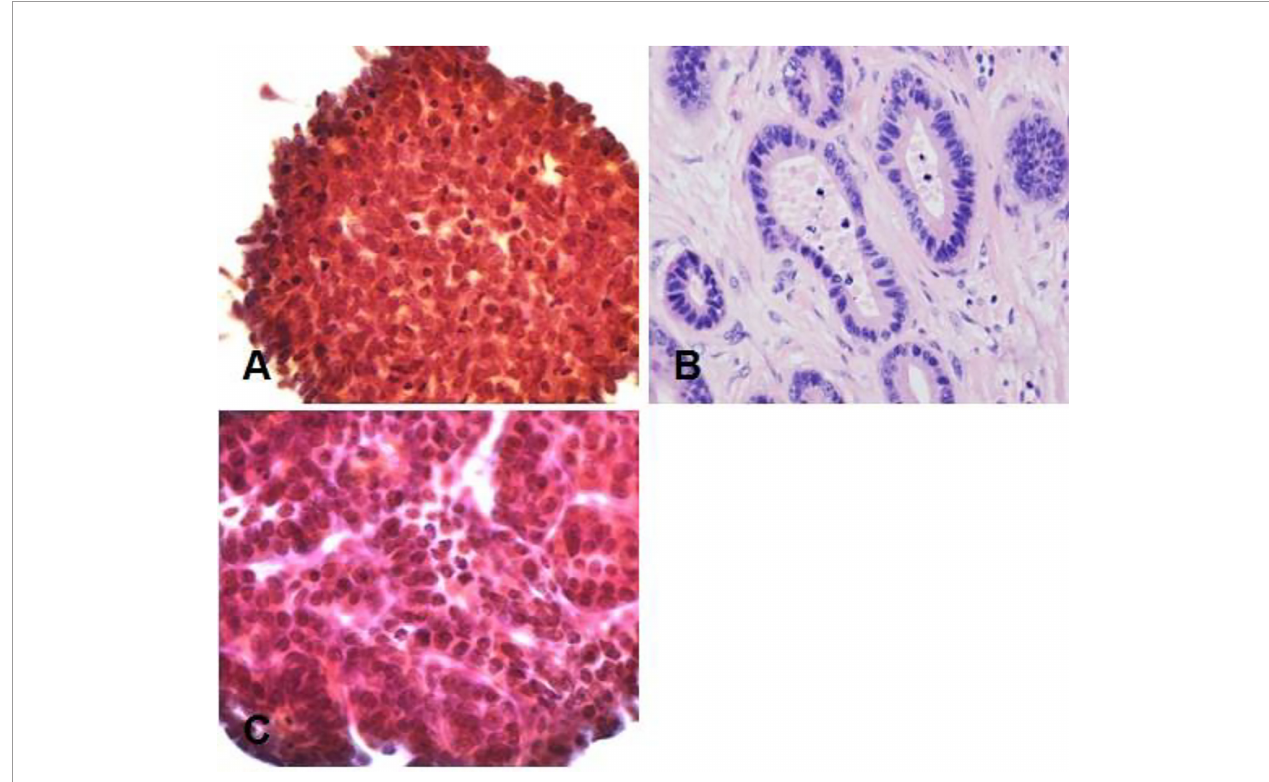
FIGURE 3 | Pathological results. (A) Duodenal adenocarcinoma. (B) Moderately differentiated adenocarcinoma (Lauren classi fi cation: intestinal type) at the esophagogastric junction. (C) Pancreatic adenocarcinoma at the pancreatic body. Hematoxylin – eosin (H&E) staining of biopsy samples (40×) magni fi cation.